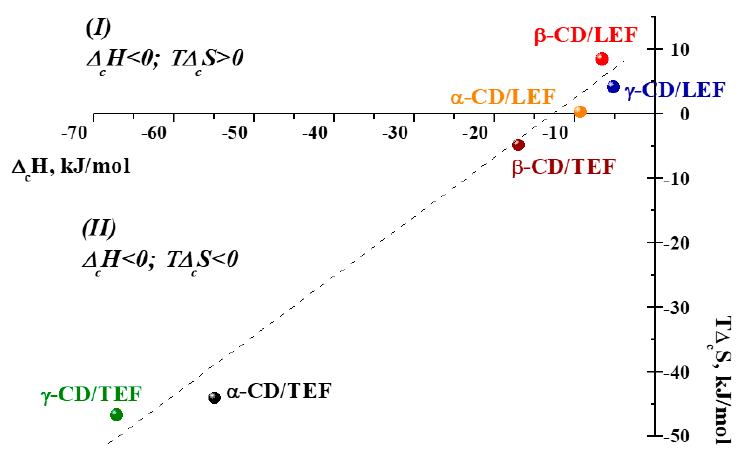
Figure 4. Enthalpy–entropy compensation for complex formation of CDs with LEF and TEF at 298.15